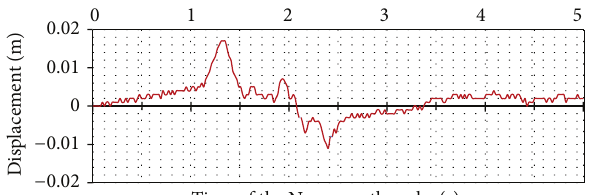
Figure 5: Input data from Nagan earthquake record according to displacement in the vertical axis (m) and time in horizontal axis